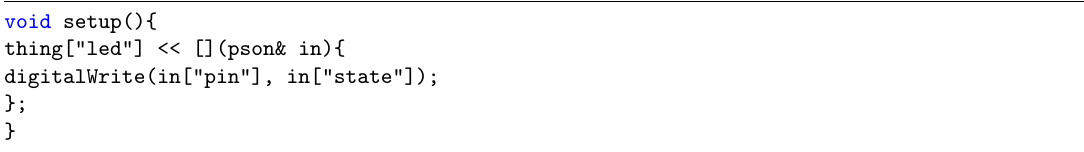
Figure 5. Thinger.io code example for controlling an arbitrary digital